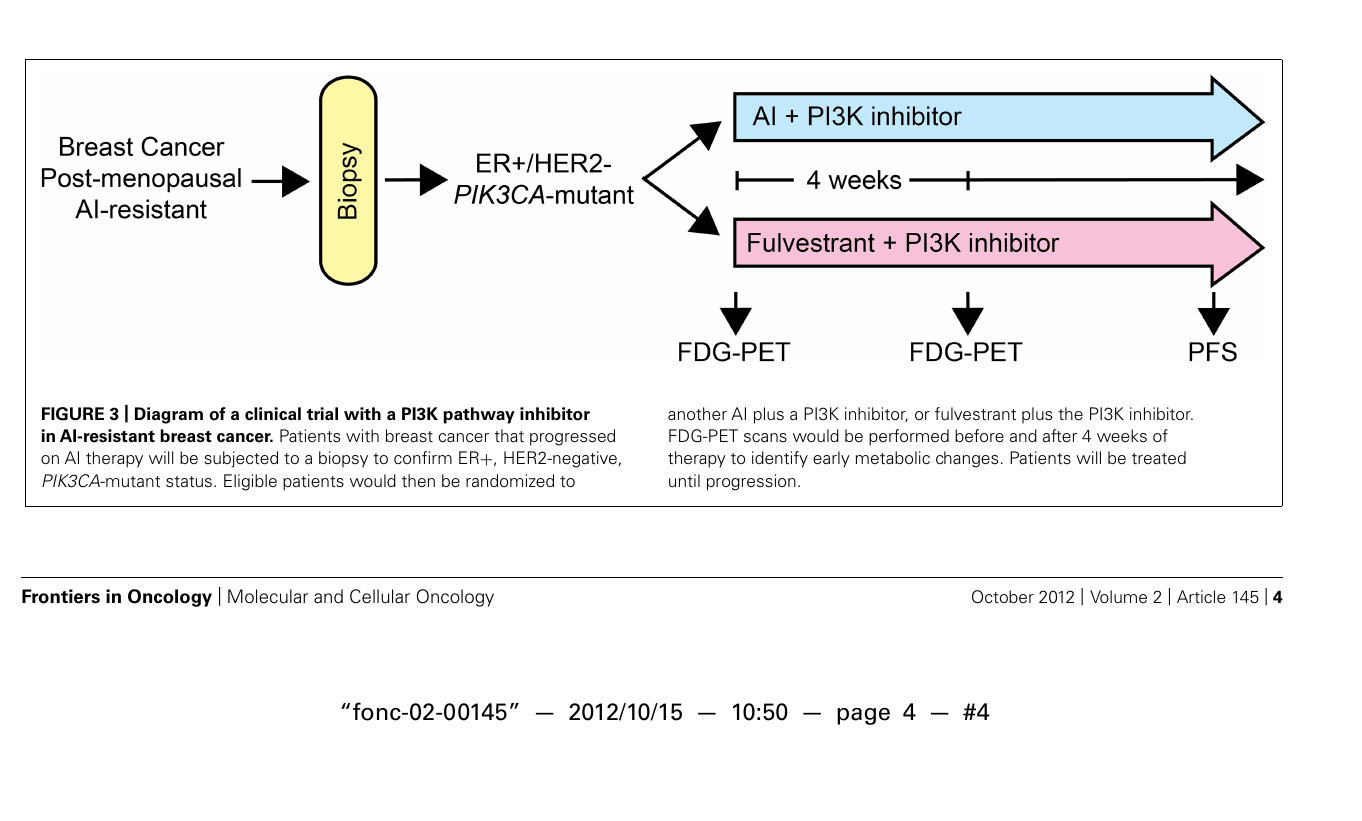
another AI plus a PI3K inhibitor, or fulvestrant plus the PI3K inhibitor. FDG-PET scans would be performed before and after 4 weeks of therapy to identify early metabolic changes. Patients will be treated until